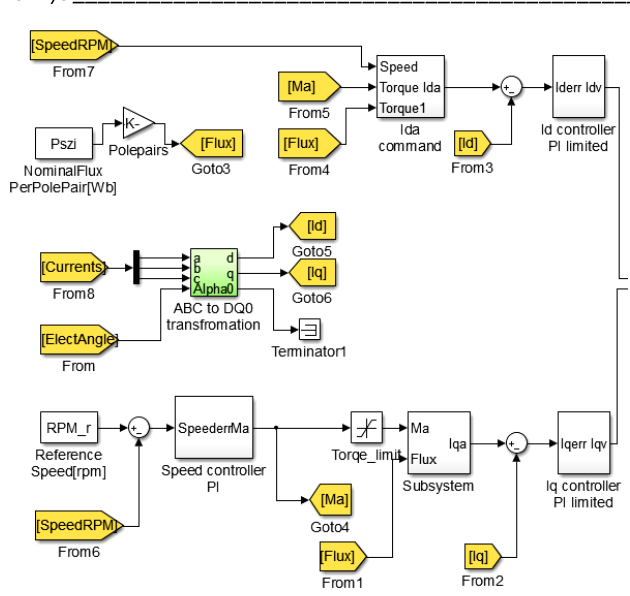
Fig. 2. Simulink model, part 1 (controllers).